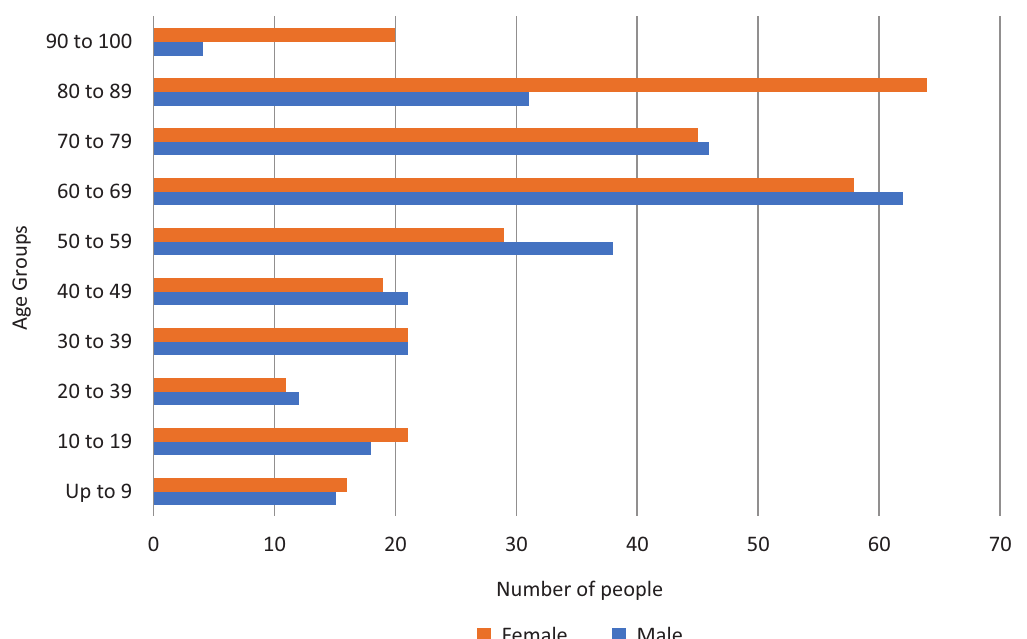
Figure 3. Population of Nijo by age group, male and female (2015). Source: Nijo Community Association (2015). ber men in the 80–89 and 90–99 categories.